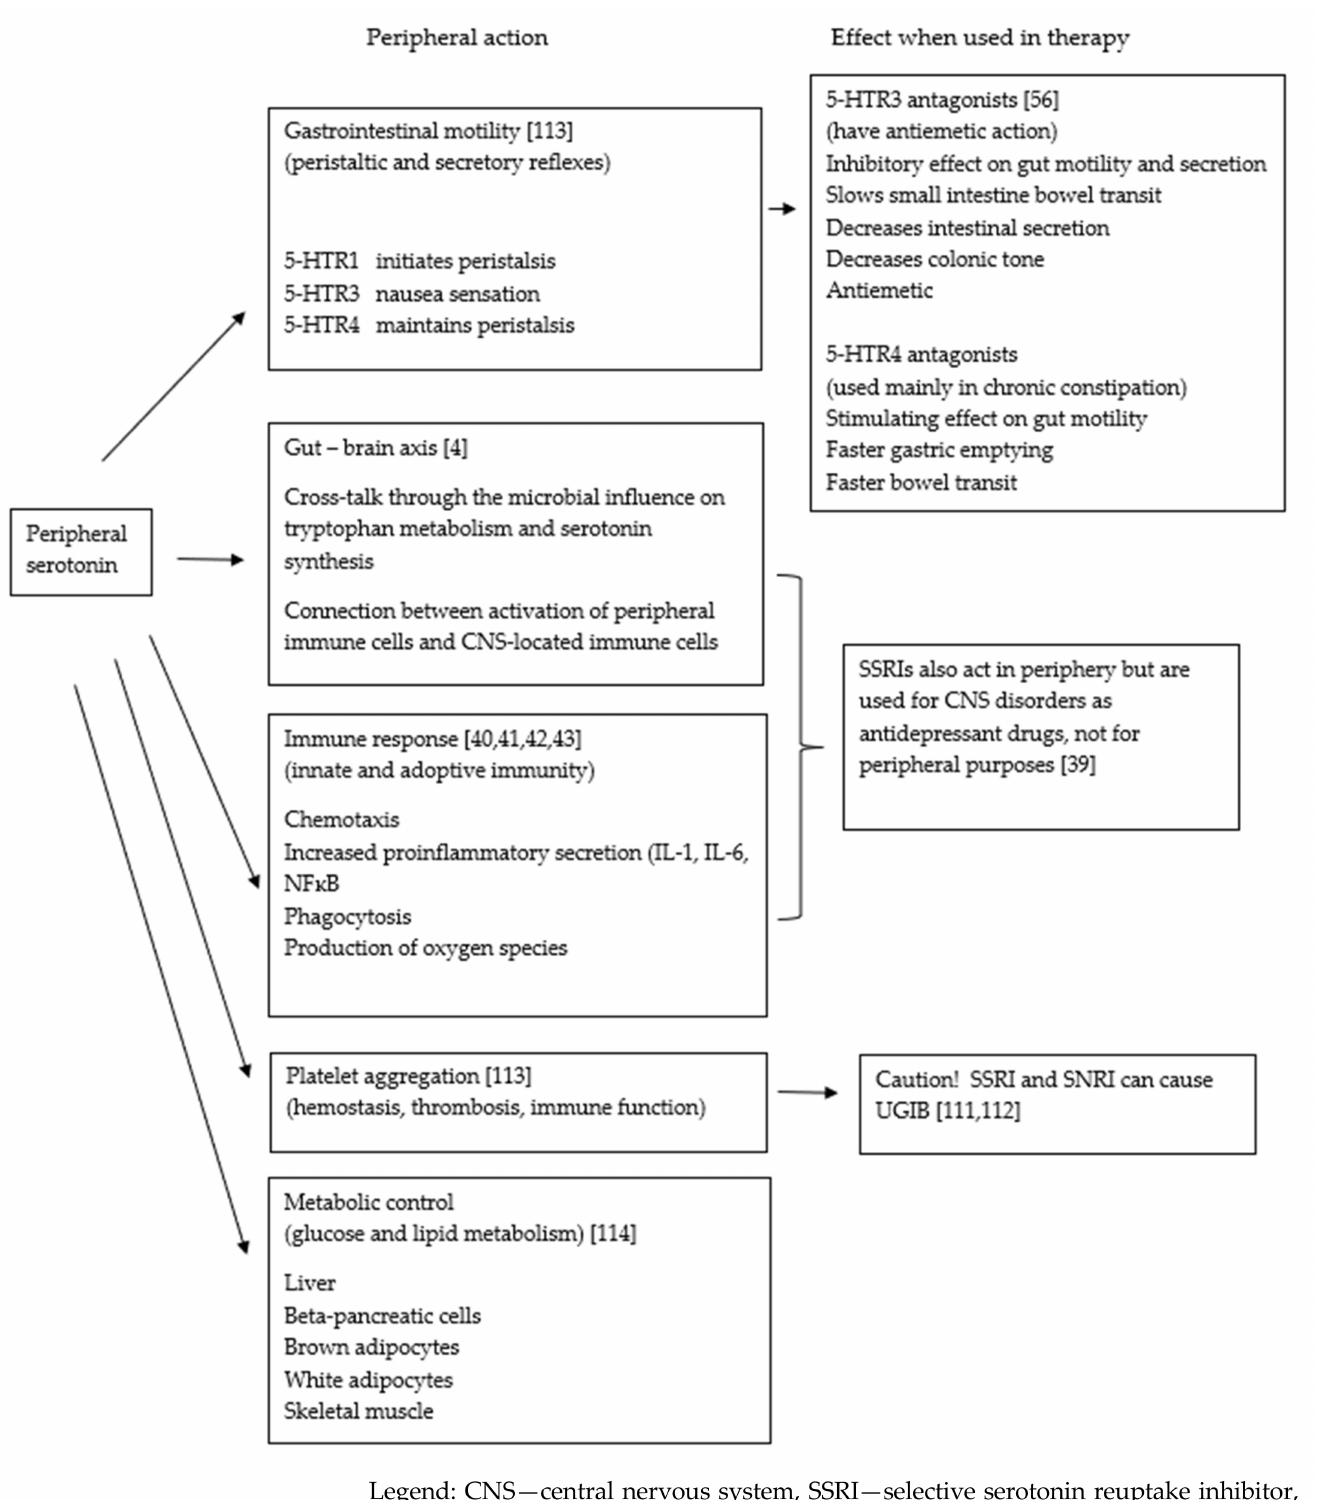
Figure 2. Peripheral effects of acting on serotonin receptors and therapeutic outcomes